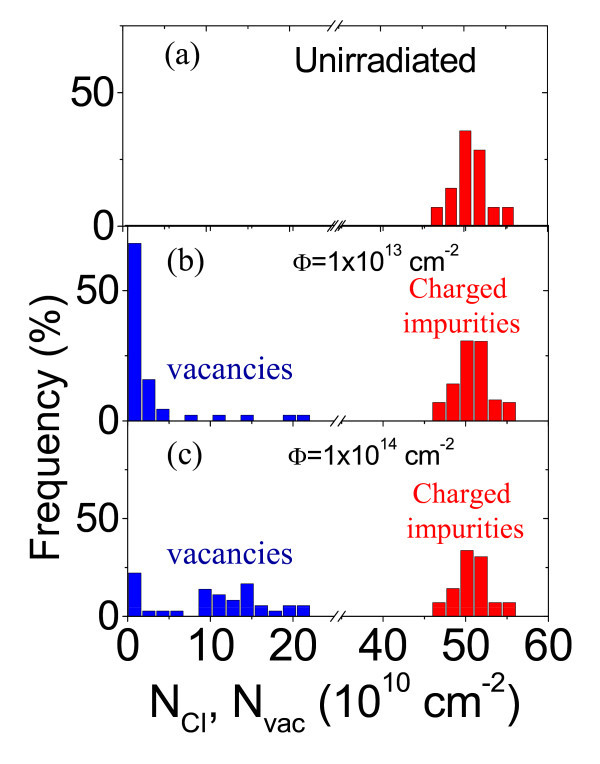
Histograms of the locally measured densities of charged impurities and vacancies in pristine and ion irradiated graphene. Charged impurities density in pristine graphene (a). Charged impurities and vacancy densities in irradiated graphene with 500 keV C+ ions at fluences 1 × 1013 cm-2 (b) and 1 × 1014 cm-2 (c), respectively.